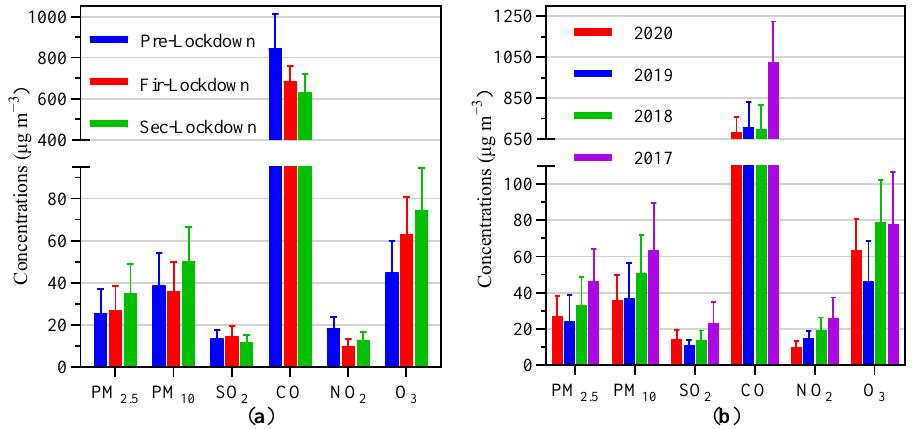
Figure 2. ( a ) Stage mean concentrations of air pollutants before and during the COVID-19 periods in 2020. ( b ) comparison of pollutant concentrations during the Fir-Lockdown period in 2020 with previous year of 2019, 2018, and 2017. Error bars indicate the standard deviations over multiple days (2020: the Fir-Lockdown period in 2020; 2019–2017: the same lunar period in 2019, 2018 and 2017 compared with the Fir-Lockdown period in 2020, respectively).